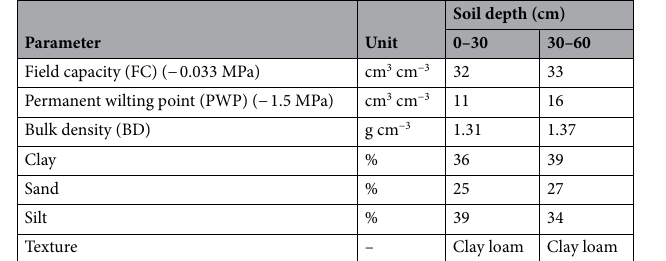
Table 1. The physical characteristic of soil in the field used for evaluation of genetic diversity in Poa pratensis accessions.